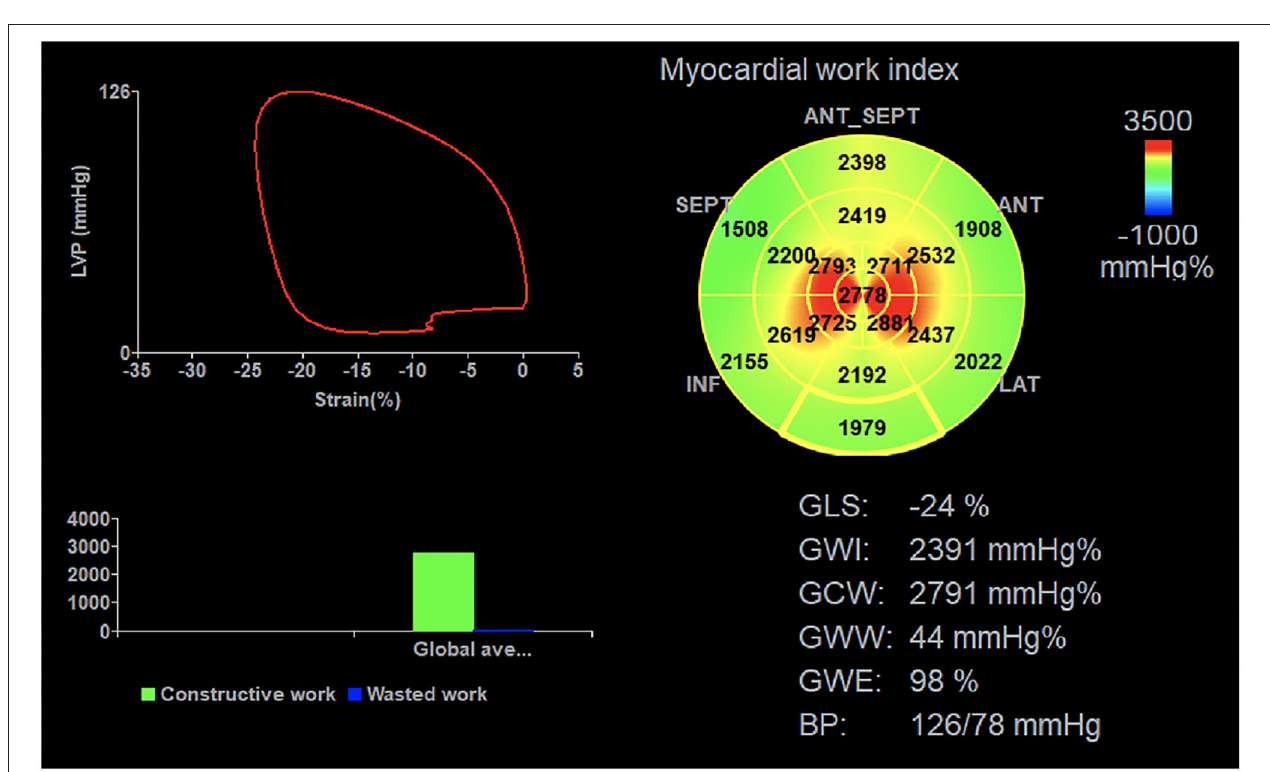
FIGURE 2 | Left ventricular myocardial work parameters were measured using the non-invasive PSL technique. Cuff contraction pressure is represented on the ordinate and longitudinal strain on the abscissa. PSL, pressure-strain loop; GLS, global longitudinal strain; GWI, global work index; GCW, global constructive work; GWW, global wasted work; GWE, global work efficiency, BP blood pressure.